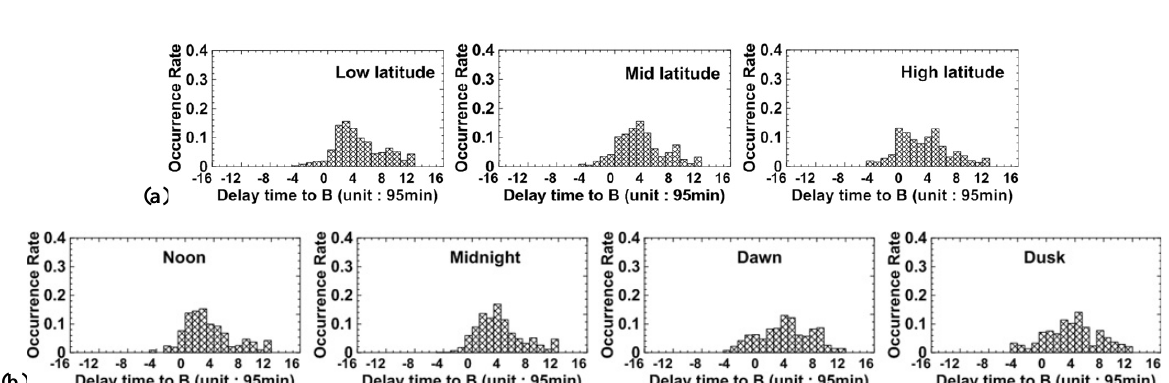
Fig. 14. Distribution of delay times of the storm-time density changes in respect to IMF B at different latitudes containing all local time sectors (a) and at different local time sectors containing all latitudes (b)